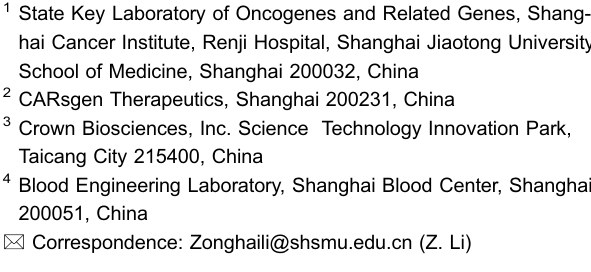
Figure 2. In vitro cytotoxic activity and cytokine release of MSLN-targeted CAR T cells and antitumor activity of the modi fi ed Tcells against established pancreatic cancer PDX tumor models in vivo . (A) Modi fi ed T cells were coincubated with tumor cells for 18 h at different effector: target ratios. Cell lysis was determined through a standard nonradioactive cyto- toxic assay. Each data point is the mean ± SEM of triplicates. (B) The modi fi ed T cells were cocultured with tumor cells for 24 h. The levels of TNF- α , IL-2, and IFN- γ in the supernatants were evaluated by ELISA. The results are representative of triplicates. Statistically signi fi cant difference is marked by